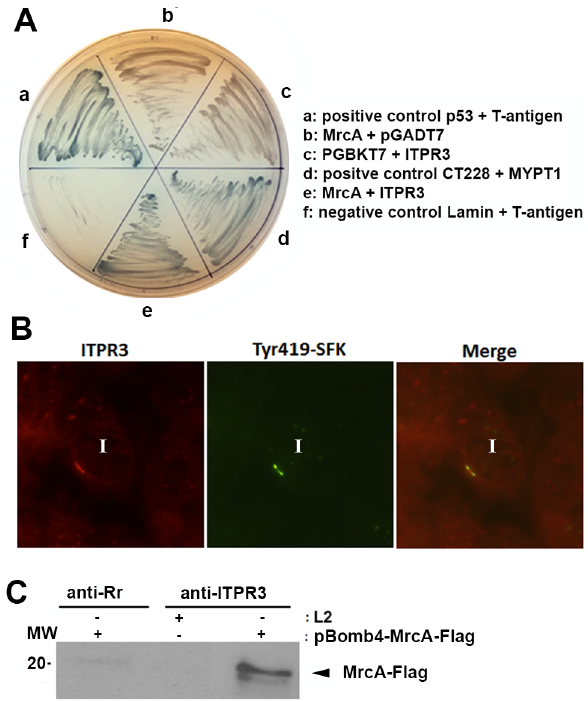
Fig 1. Interaction of MrcA with ITPR3. (A) Yeast-2-hybrid identification of ITPR3 as a binding partner of MrcA. Interactions in the yeast-two hybrid were verified by screening diploids grown on SD-Trp Leu and high stringency SD-Trp Leu His Ade + α Gal. Interactions were detected between the positive controls p53 + T-antigen (a) and CT228 and MYPT1 (d) as well as MrcA and ITPR3 (e) as evidenced by α -Galactosidase activity on Trp Leu His Ade resulting in blue yeast colonies. No interactions were detected with MrcA and pGADT7 (b), pGBKT7 and ITPR3 (c) and the negative control Lamin + T antigen (f). (B) ITPR3 is recruited to the inclusion and colocalizes with active kinase. Hela cells were infected with C . trachomatis L2. 24 hrs post infection cells were fixed and immunolabeled with anti-active Src-family kinase (Tyr419) (green) and anti-ITPR3 (red). Specimens were examined by confocal microscopy. ITPR3 shows discrete microdomain-like staining patterns that colocalize with active Src kinase. Inclusions are indicated by “I”. Bar = 10 μ m. (C) ITPR3 interacts with MrcA. T150 flasks of Hela cells were infected with C . trachomatis transformed with pBomb4- MrcA -Flag or parental C . trachomatis L2. 48 hrs post infection cells were harvested and lysate prepared for co-immunoprecipitation. The supernatant from infected lysate was added to Protein-A beads that had been pre-loaded with anti-ITPR3 or with anti- R . rickettsii antibodies (anti-Rr). Immunoblots were probed with